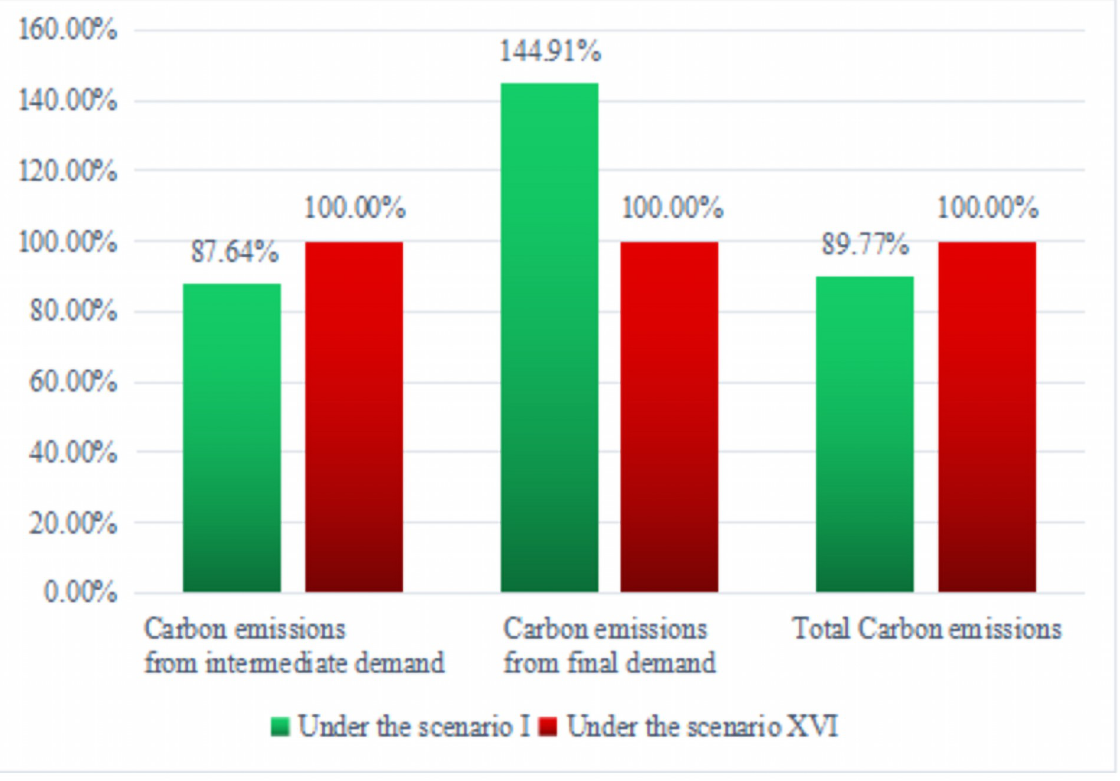
Fig 1. The carbon emissions structure under two